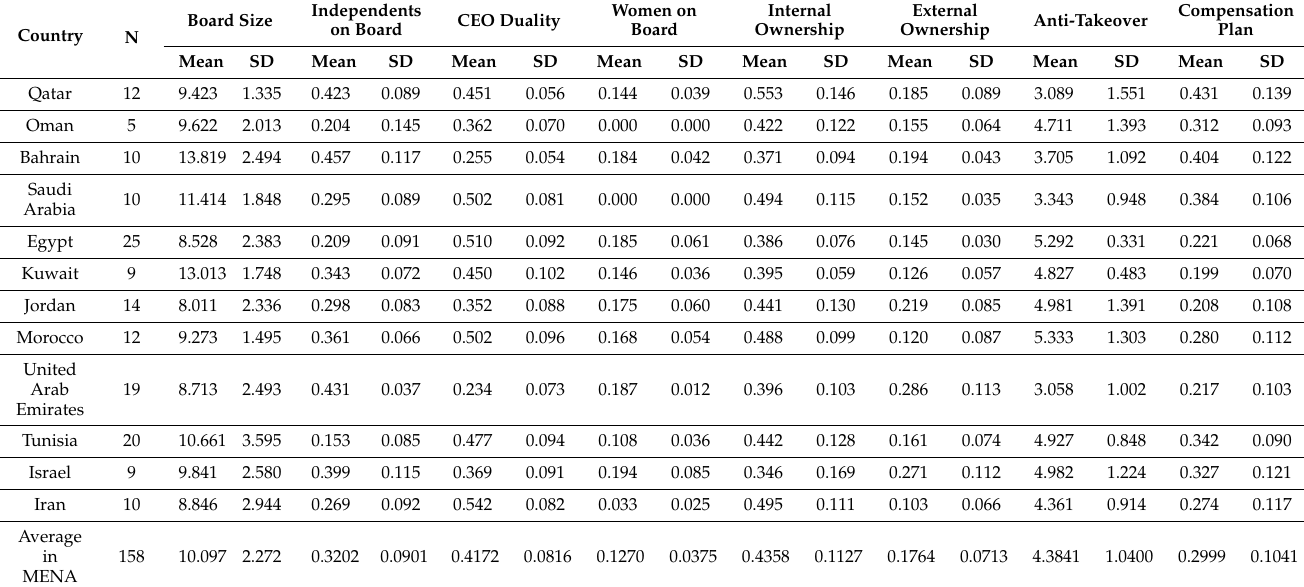
Table 4. Internal Corporate Governance Indicators.